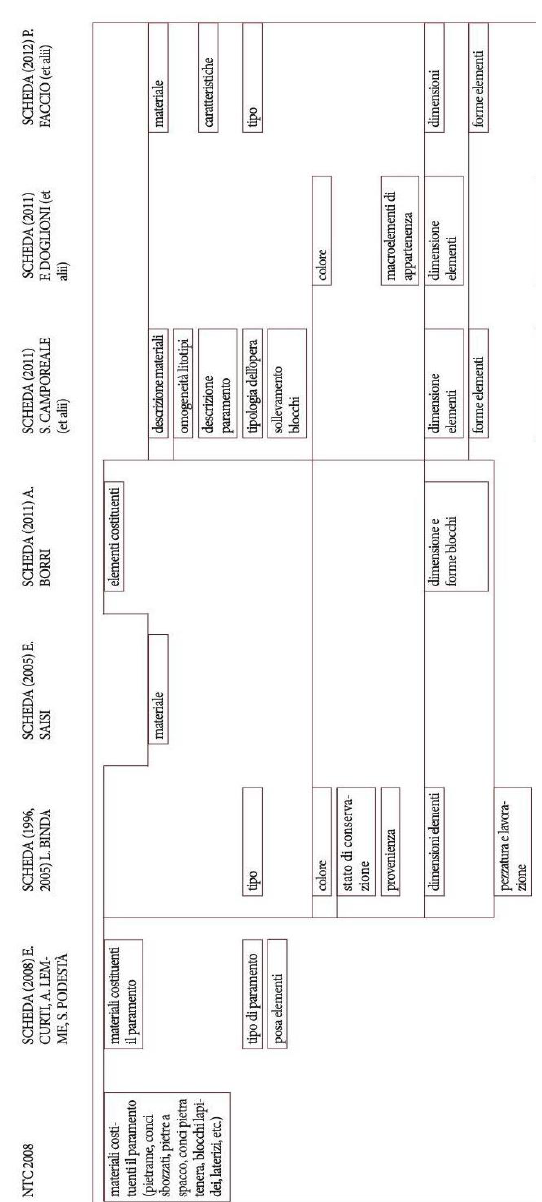
Figure 3. Survey